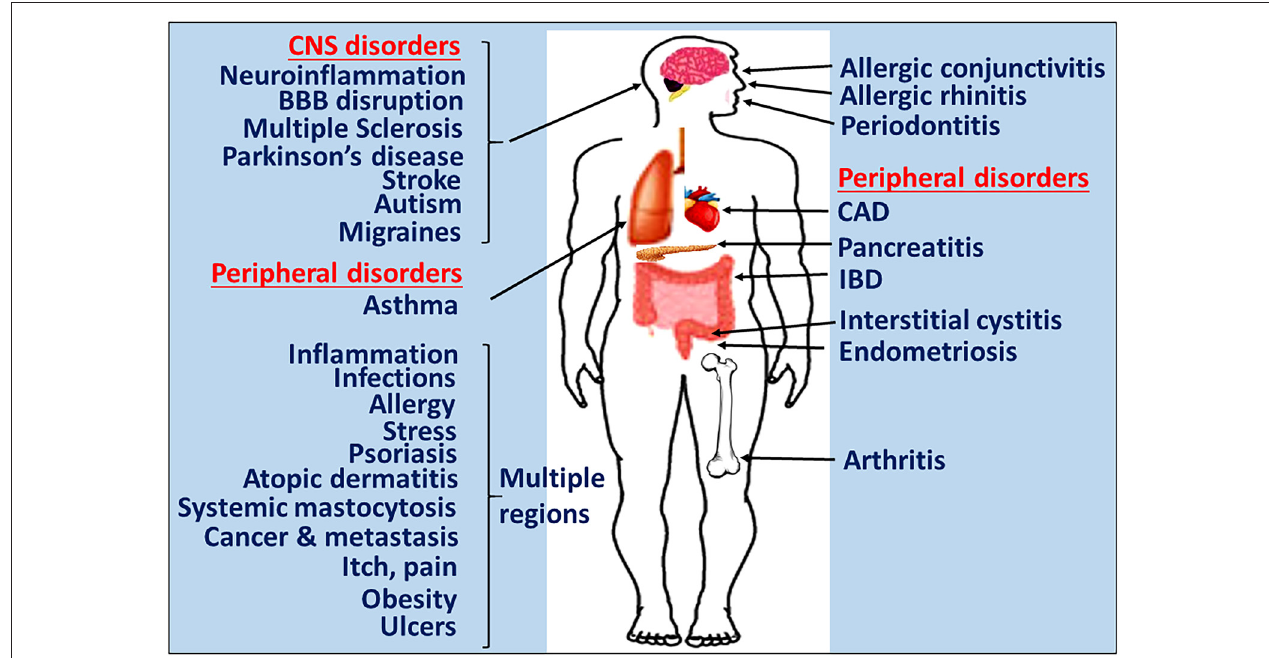
FIGURE 1 | Mast cells in inflammatory diseases. Mast cells play a crucial role in the pathogenesis of many inflammatory diseases of various organs. Certain systemic inflammatory conditions could affect and augment neuroinflammation and neurodegeneration. Therefore, targeting mast cells represents a potentially novel approach to developing the next generation of precision guided therapeutic strategies for the treatment of inflammatory diseases. IBD, inflammatory bowel disease; CAD, coronary artery disease; BBB, blood-brain